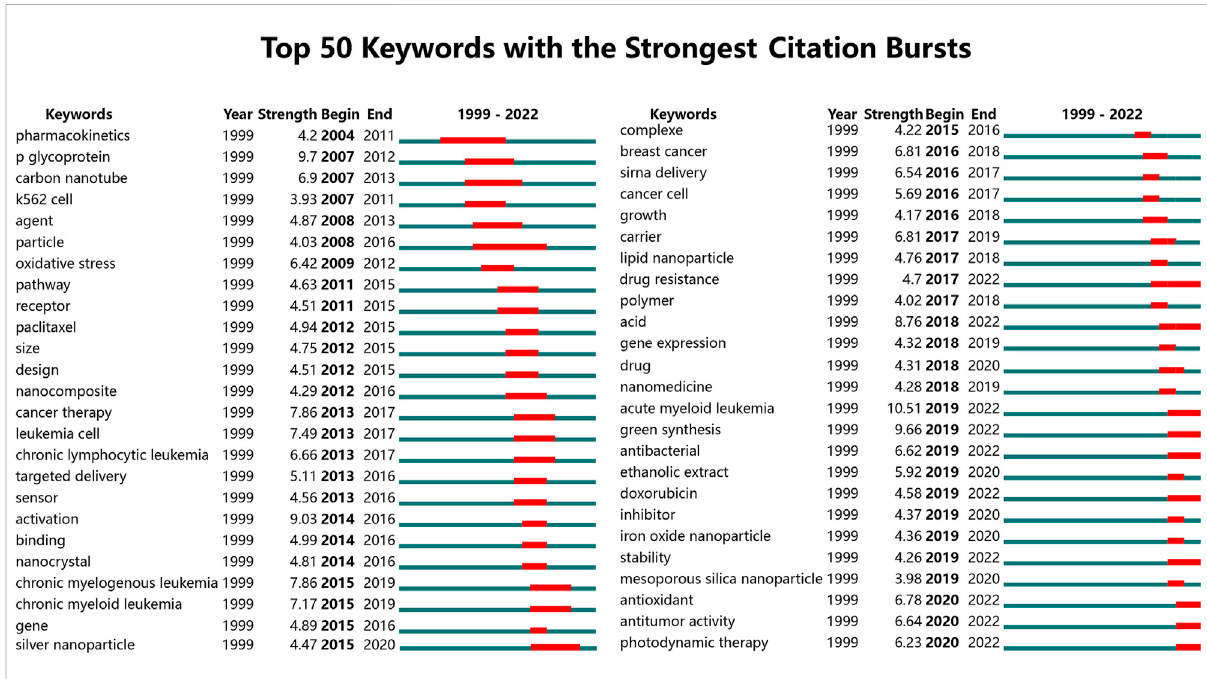
FIGURE 8 Top 50 keywords with the most vigorous citation burst r (sorted by the strength). Notes: The Blue bars mean the published reference; the red bars mean citation burstiness.